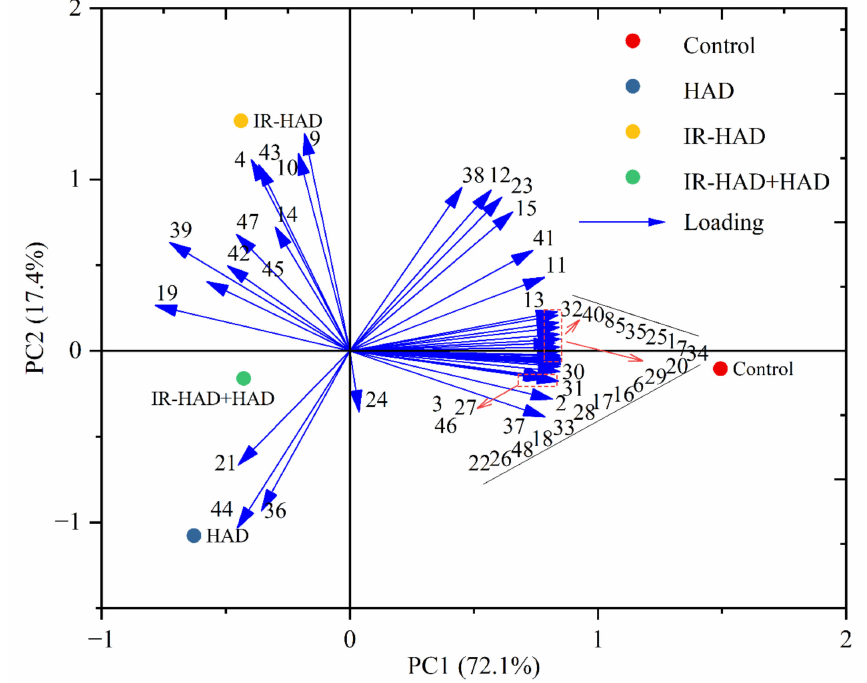
Figure 7. PCA biplot of volatile compounds in chrysanthemum cakes dried by different methods: Control: freeze-drying; HAD, hot air drying at 65 ◦ C, IR-HAD, combined infrared and hot air drying at 65 ◦ C, IR-HAD + HAD, sequential IR-HAD and HAD at 65 ◦ C (aroma compound numbers correspond to the numbers in Table